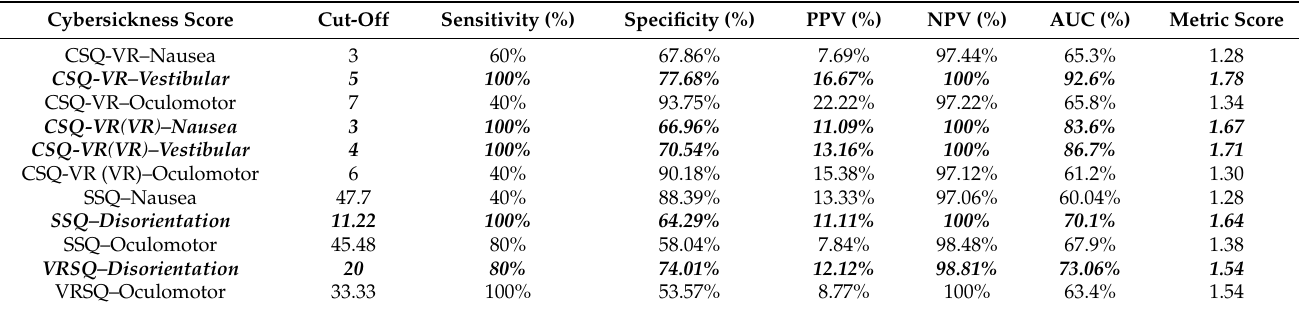
Table 7. Psychometric Properties of the CSQ-VR, SSQ, and VRSQ Vestibular/Disorientation Scores in detecting Reaction Speed Decline.